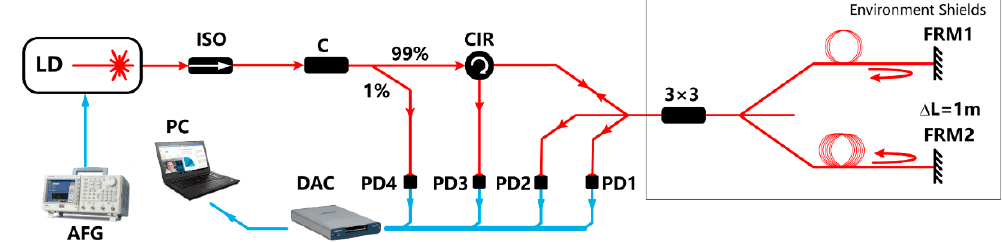
Figure 3. The experimental setup for researching the influence of the AAM and its suppression.